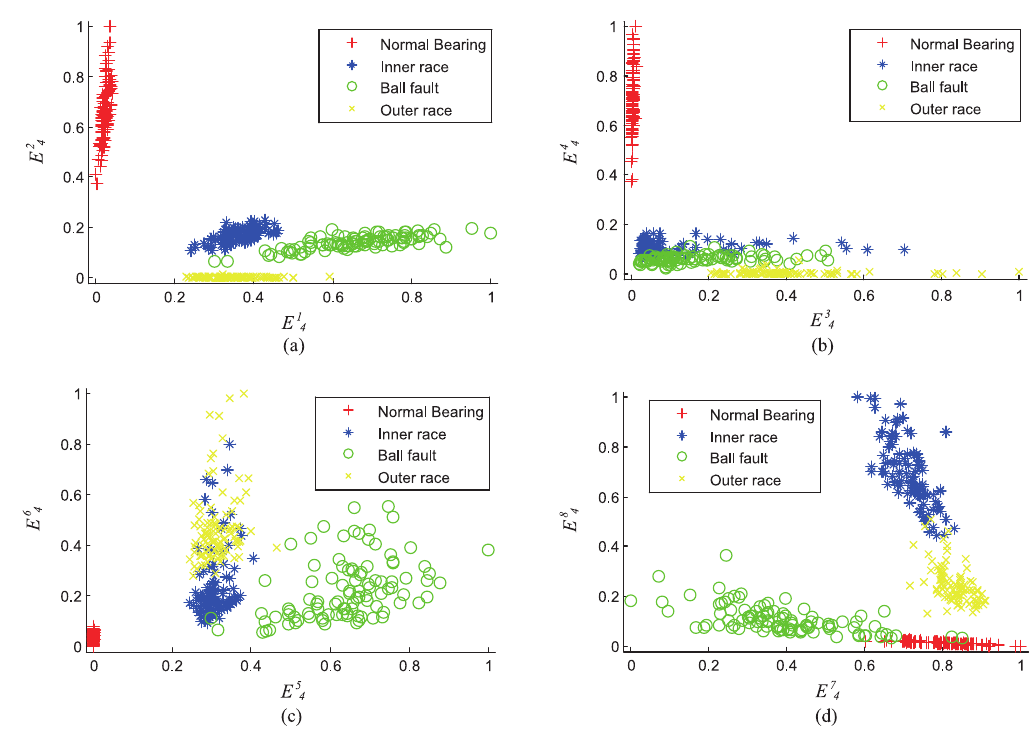
Fig. 5. The spatial distribution of the wavelet packet energy features ( E n 4 denotes the n th sub band energy at level